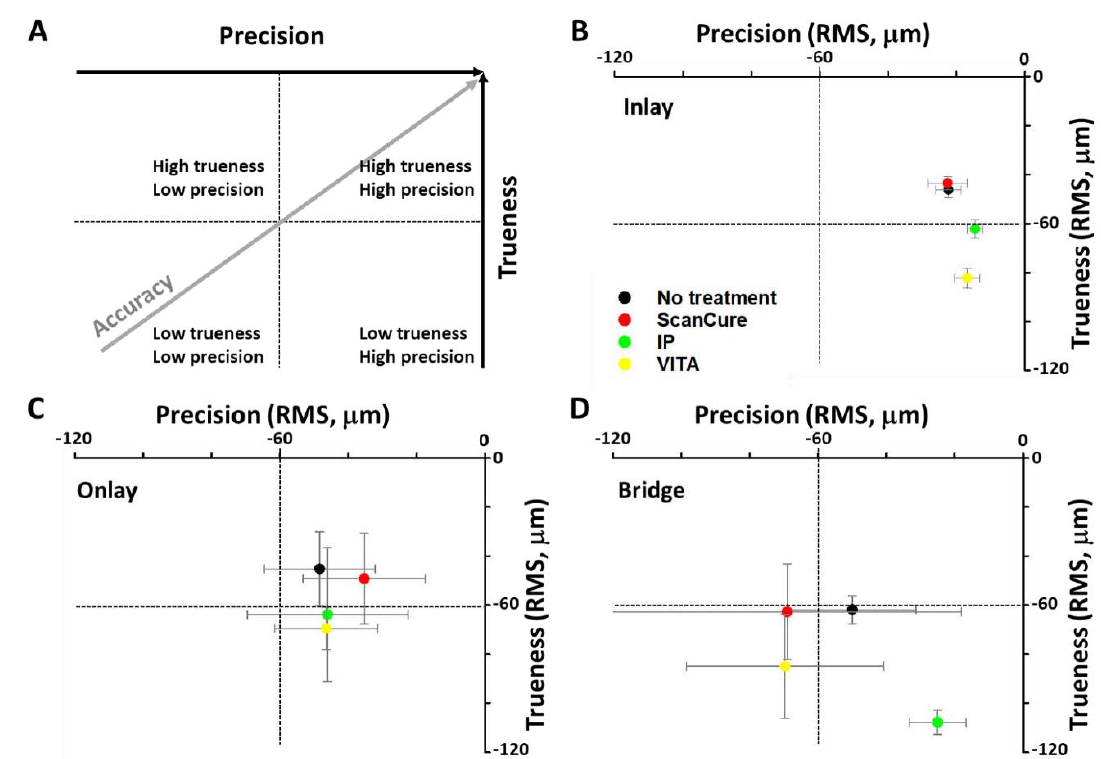
Figure 6. Accuracy of four experimental groups (ScanCure, IP, VITA, no treatment) in the inlay, onlay and bridge reference models. ( A ) Scheme of the correlation between precision and trueness, ( B ) inlay model, ( C ) onlay model, and ( D ) bridge model.